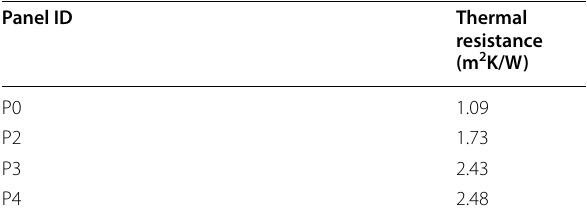
Table 3 Thermal resistance of the